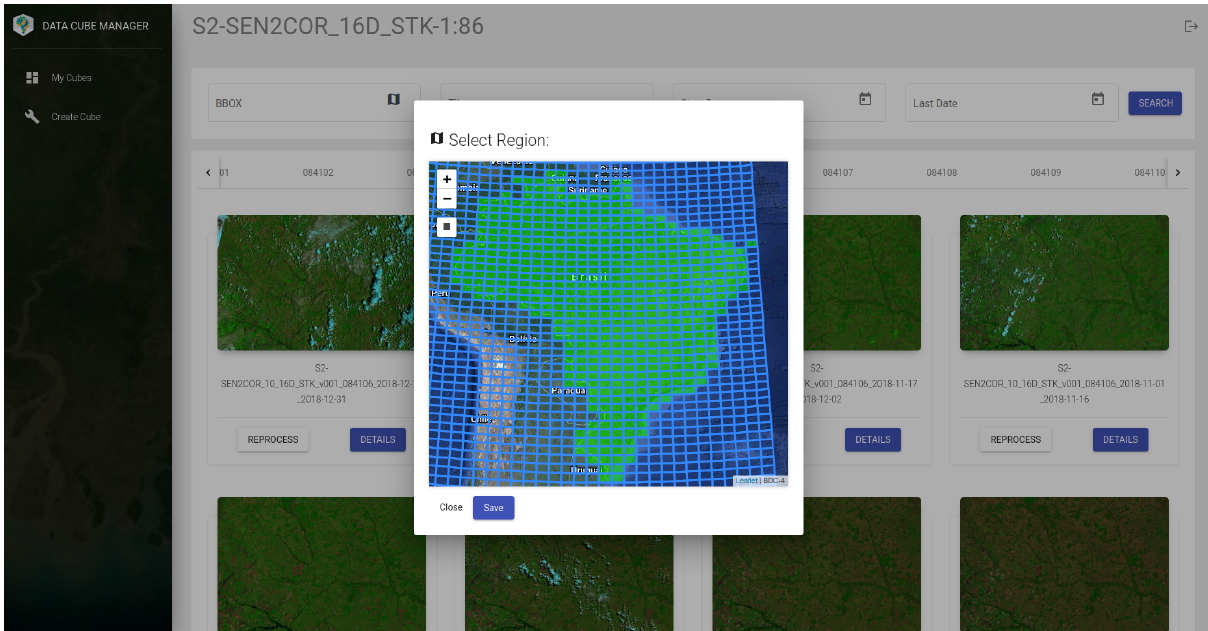
Figure 7. Graphical interface of Data Cube Builder on AWS - Data Cube Preview.